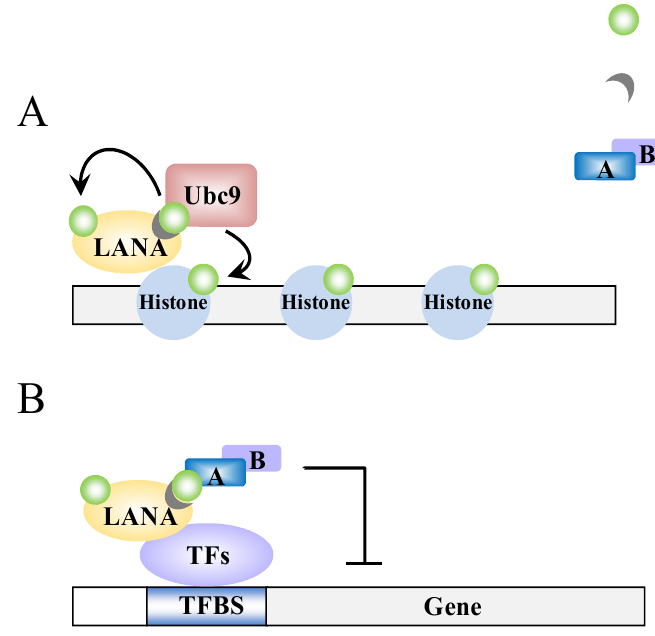
Figure 4. A model of epigenetic regulation by LANA. ( A ) LANA recruits Ubc9 to specific genomic regions and promotes sumoylation of histone proteins; ( B ) The SIM-dependent recruitment of SUMO-modified chromatin-remodeling complexes by